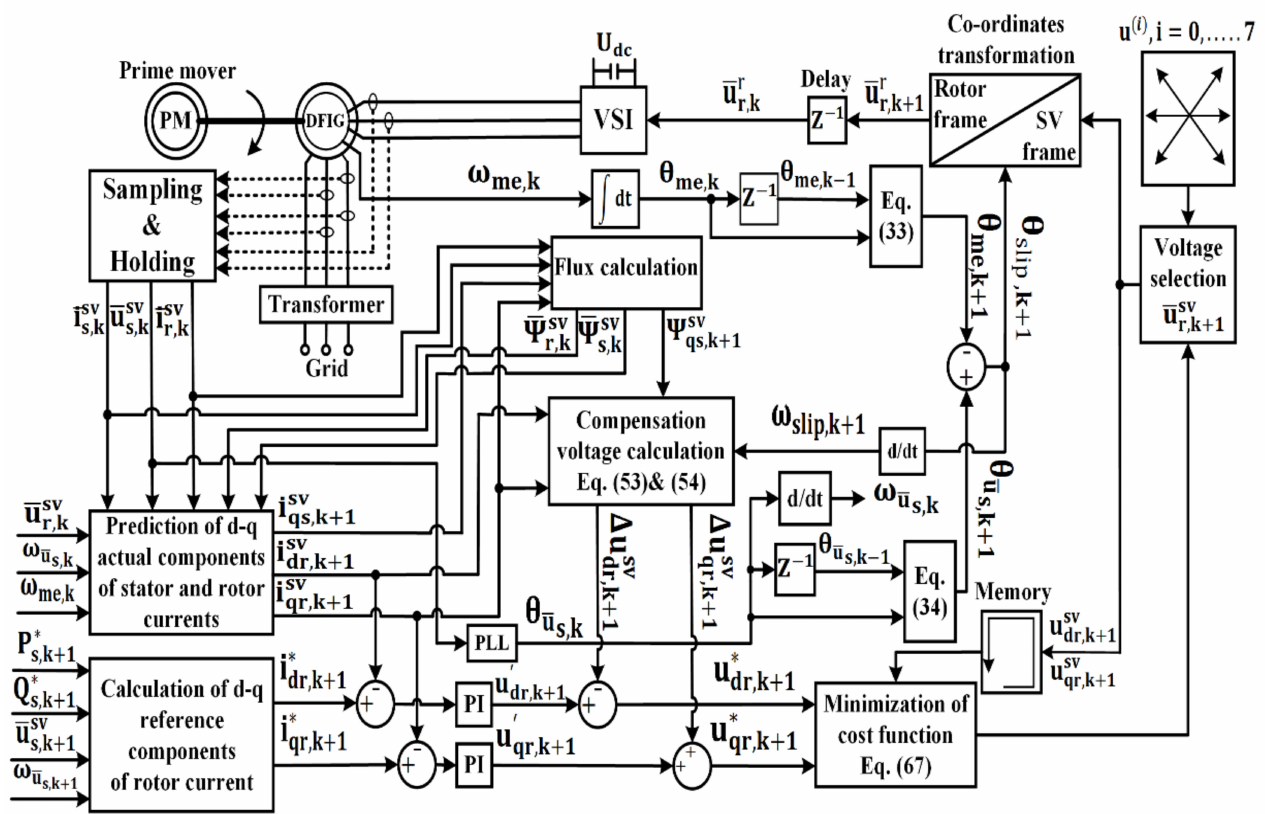
Figure 8. Proposed PVC technique for the DFIG.